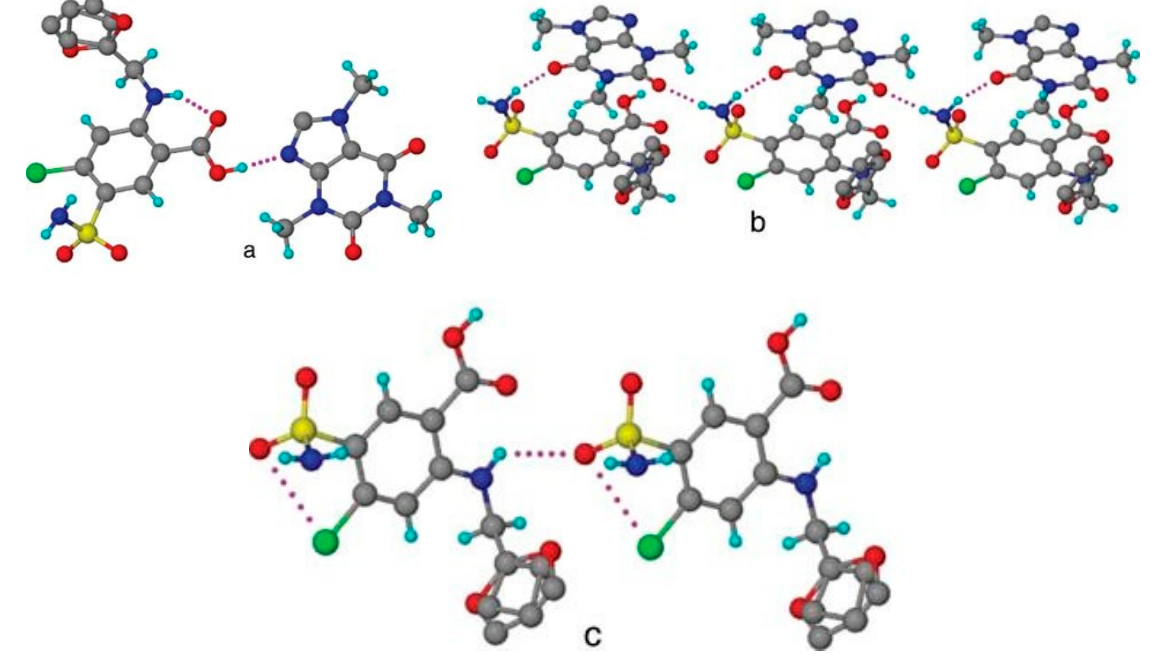
Figure 26. ( a ) O–H···N hydrogen bond between COOH group of furosemide and imidazole N of